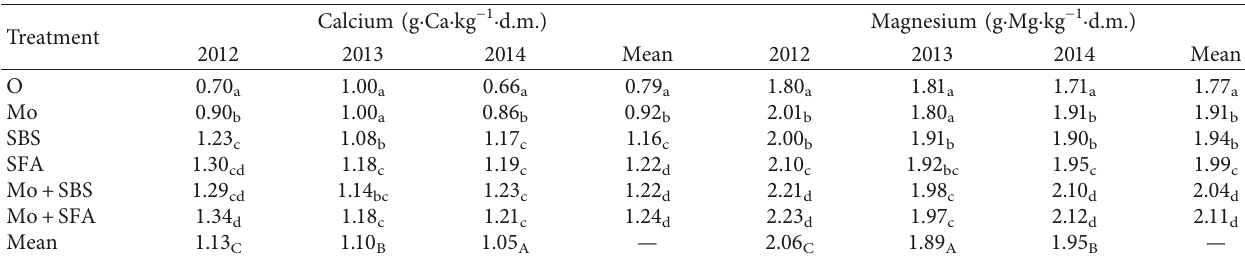
Table 6: The influence of Mo and S application on the calcium and magnesium content. Treatment